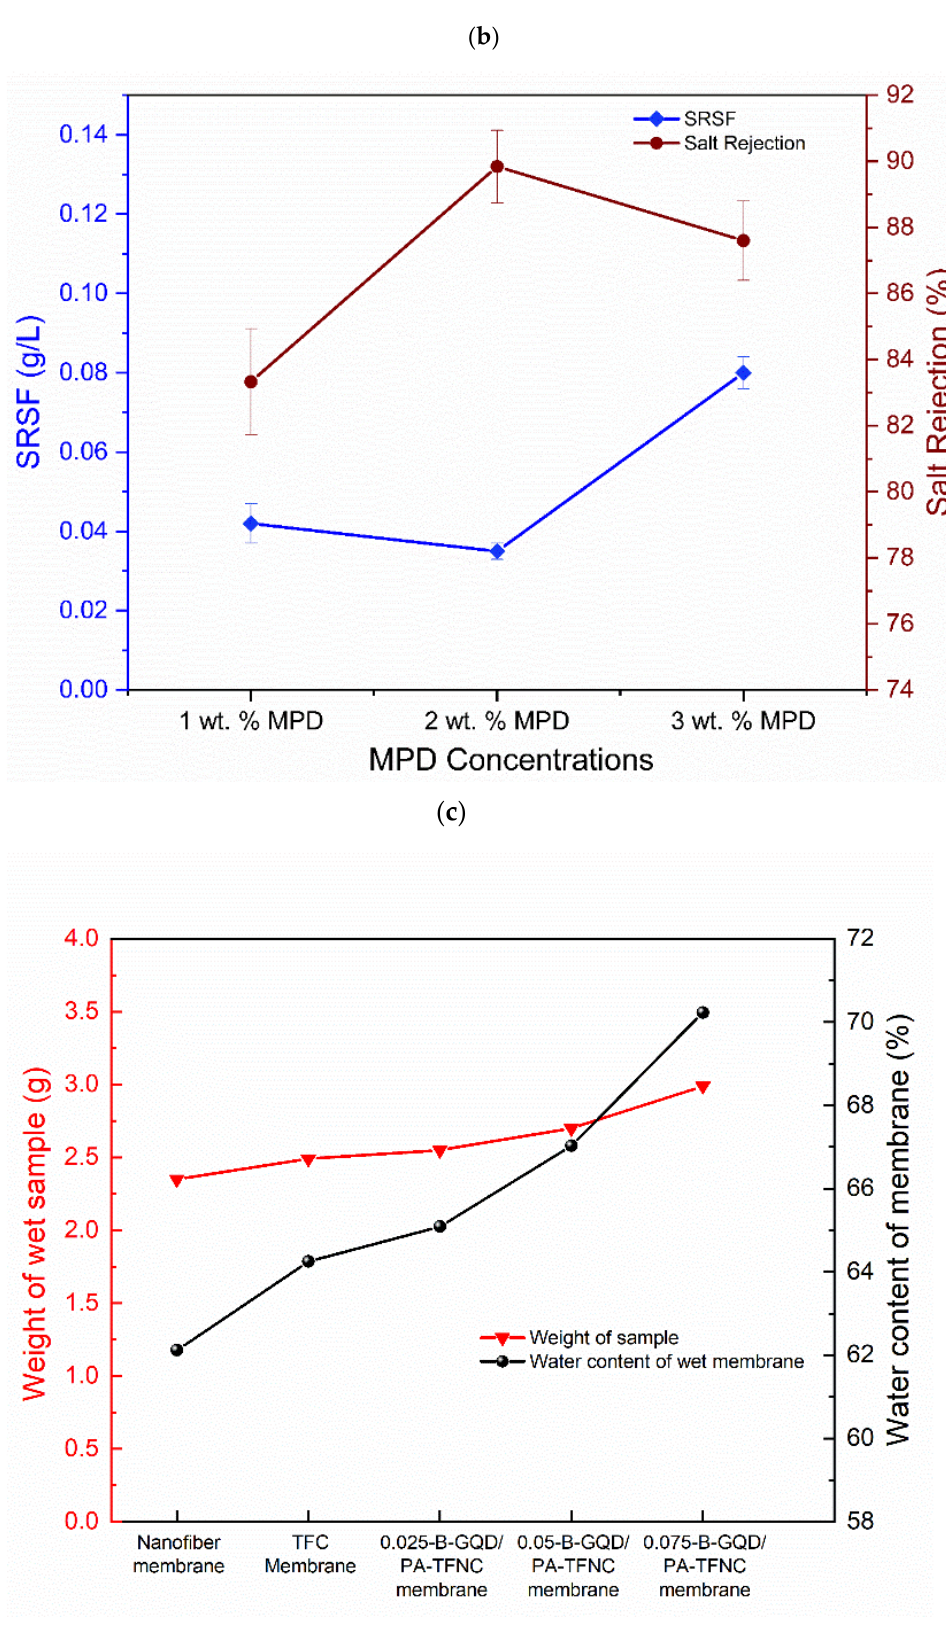
Figure 9. ( a ) Effect of MPD concentration on the water flux and solute flux of the TFC-FO membrane; ( b ) effect of MPD concentration on the SRSF and salt rejection of the TFC-FO membrane; ( c ) water content assessment of TFC and TFNC